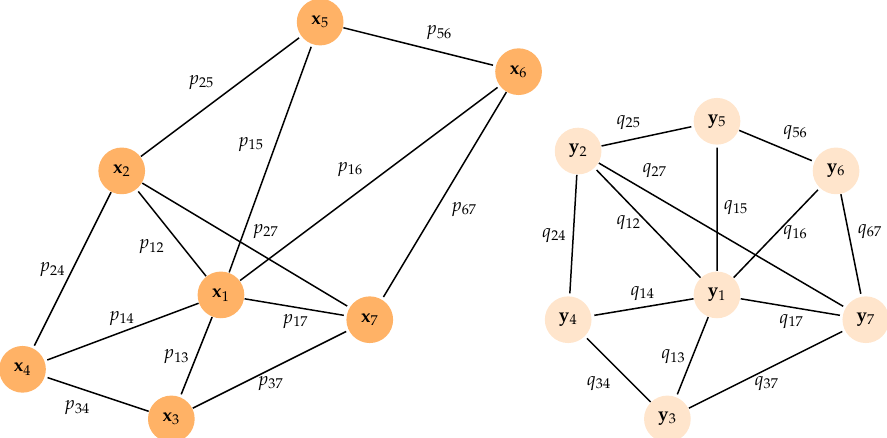
Figure A3. Illustration of a weighted undirected graph for points in x i R D and a low-order ∈ representation of the graph where y i R d . The weights p ij ( X ) in the original space are computed ∈ from distances measured in the R D d -metric of the k -neighbors of each point, whereas the